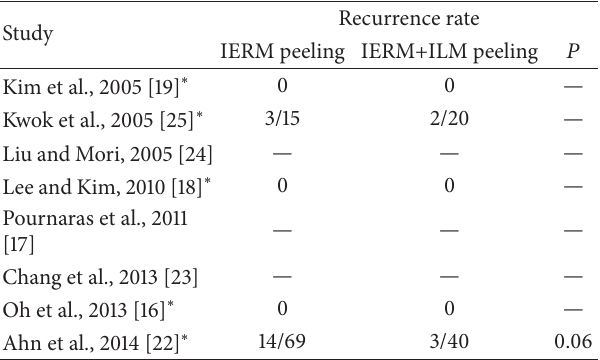
Table 5: Recurrence